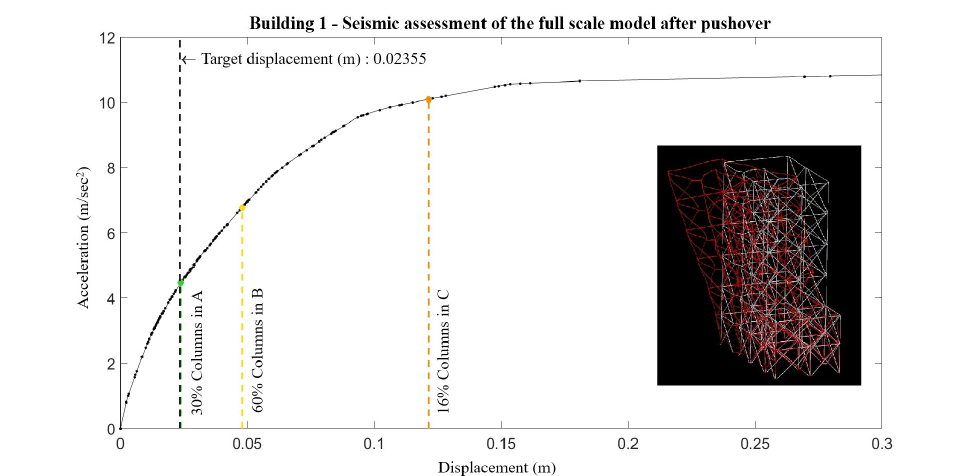
Figure 9. Building 1: Seismic assessment results of the full-scale model after